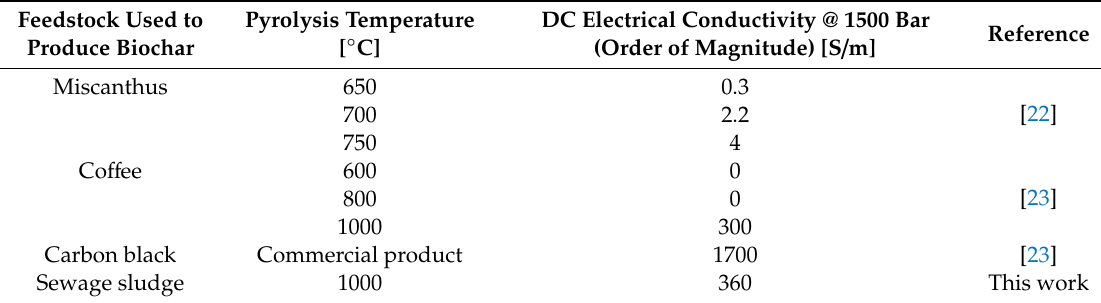
Table 2. Comparison between conductivity of di ff erent biochar produced in a wide temperature range compared with commercial carbon black.